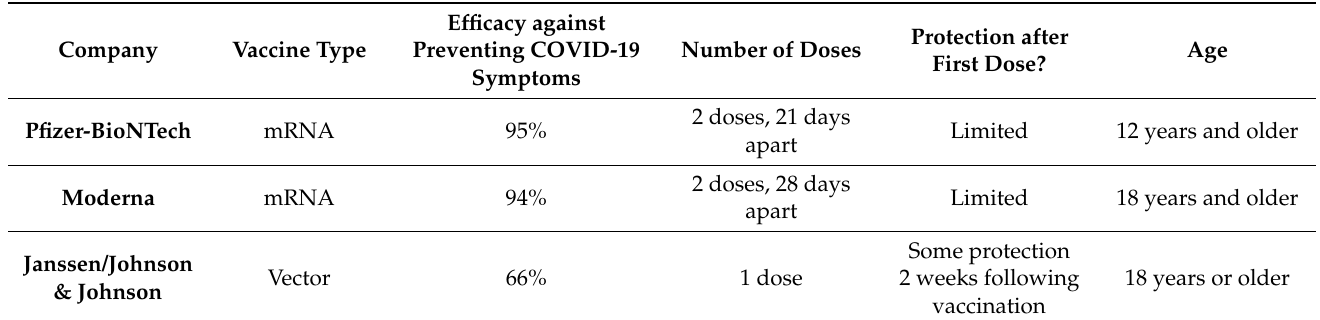
Table 2. Current vaccines authorized in the U.S for the inoculation against COVID-19